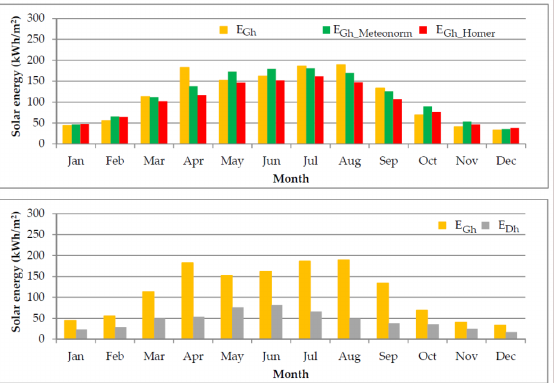
Figure 6. Monthly solar energy measured in the horizontal plane in Brasov 2020 (E Gh , E Dh ) and provided by databases (E Gh_Meteonorm and E Gh_Homer ).